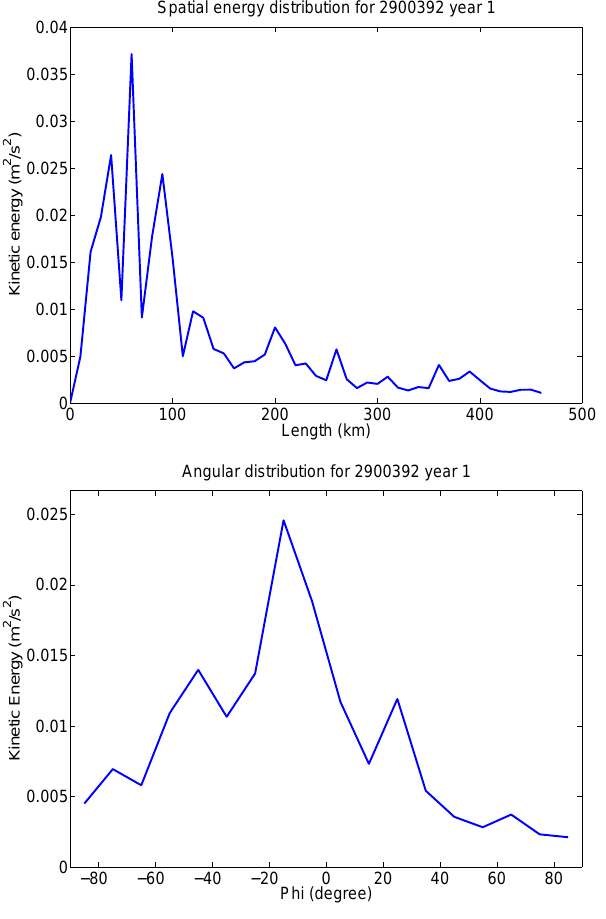
Fig. 7. Distribution of Lagrangian kinetic energy (in m 2 s − 2 ) with respect to horizontal displacement (top) and to the orientation of the flow (bottom), for float 2900392.